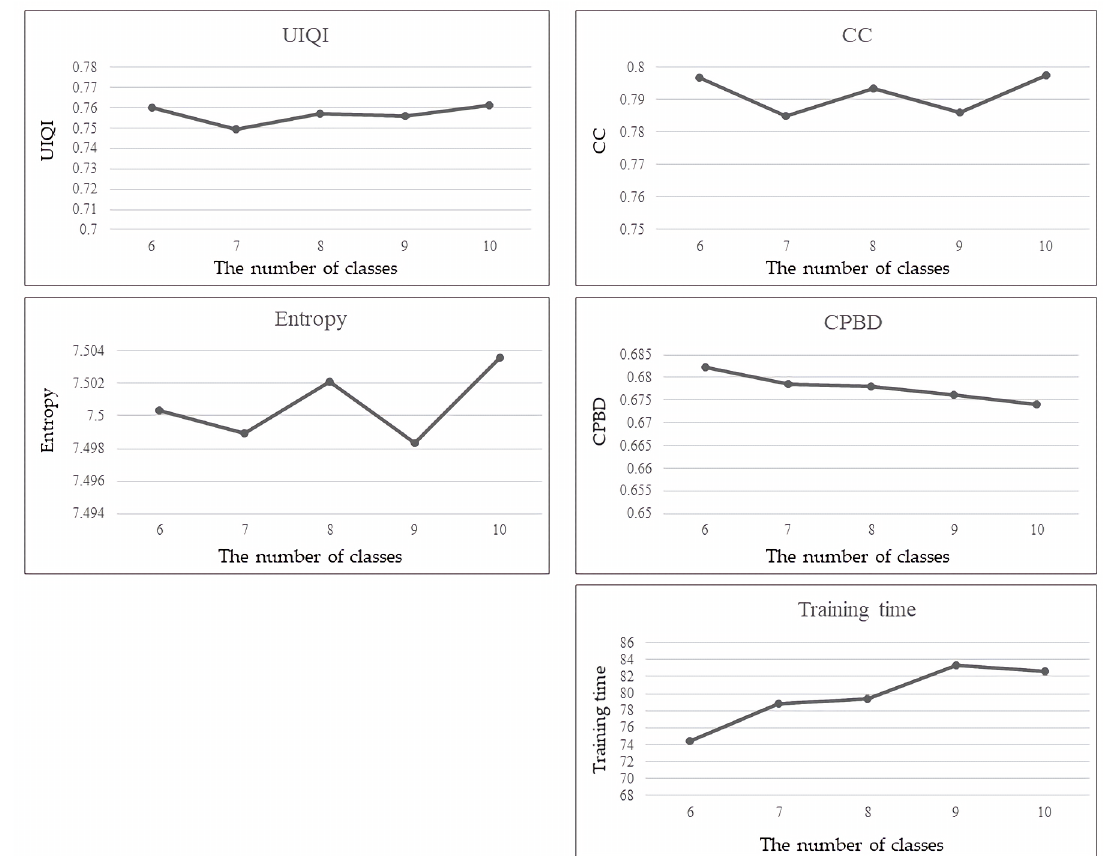
Figure 7. Statistical evaluation according to the number of classes for Site 2. UIQI, universal image quality index. CC, correlation coefficient. CPBD, cumulative probability of blur